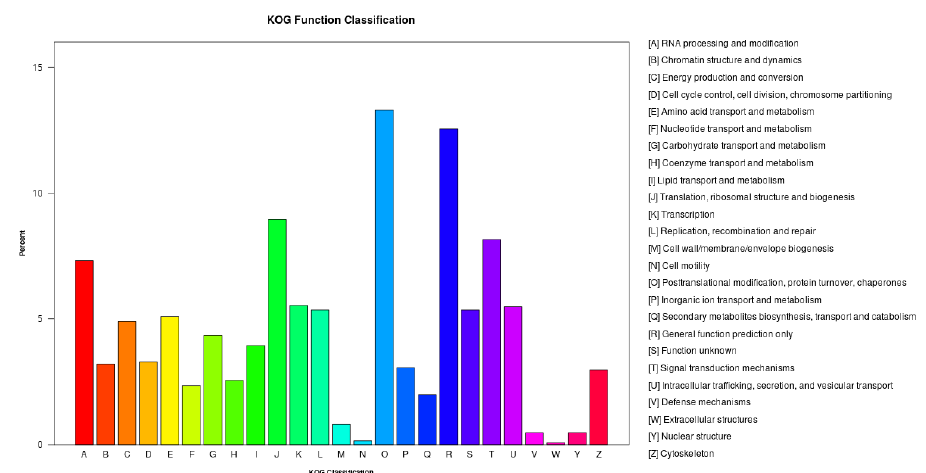
Figure 5. KOG annotation classification chart; the abscissa in the figure is the name of the 26 groups of KOG, and the ordinate is the ratio of the number of genes annotated to this group to the total number of annotated genes.